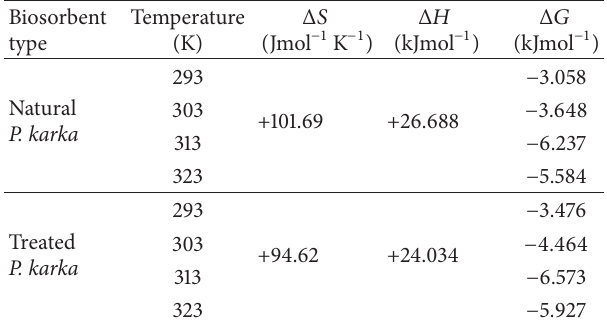
Table3:Valuesofthermodynamicparametersforthebiosorptionof mercury ions on the surface of natural P. karka and treated P. karka